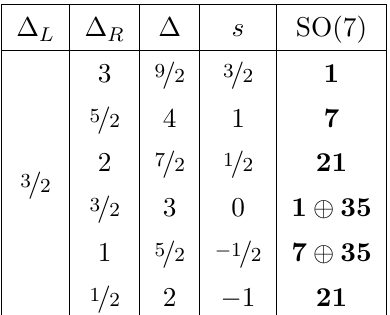
2 ; R ) solution with j